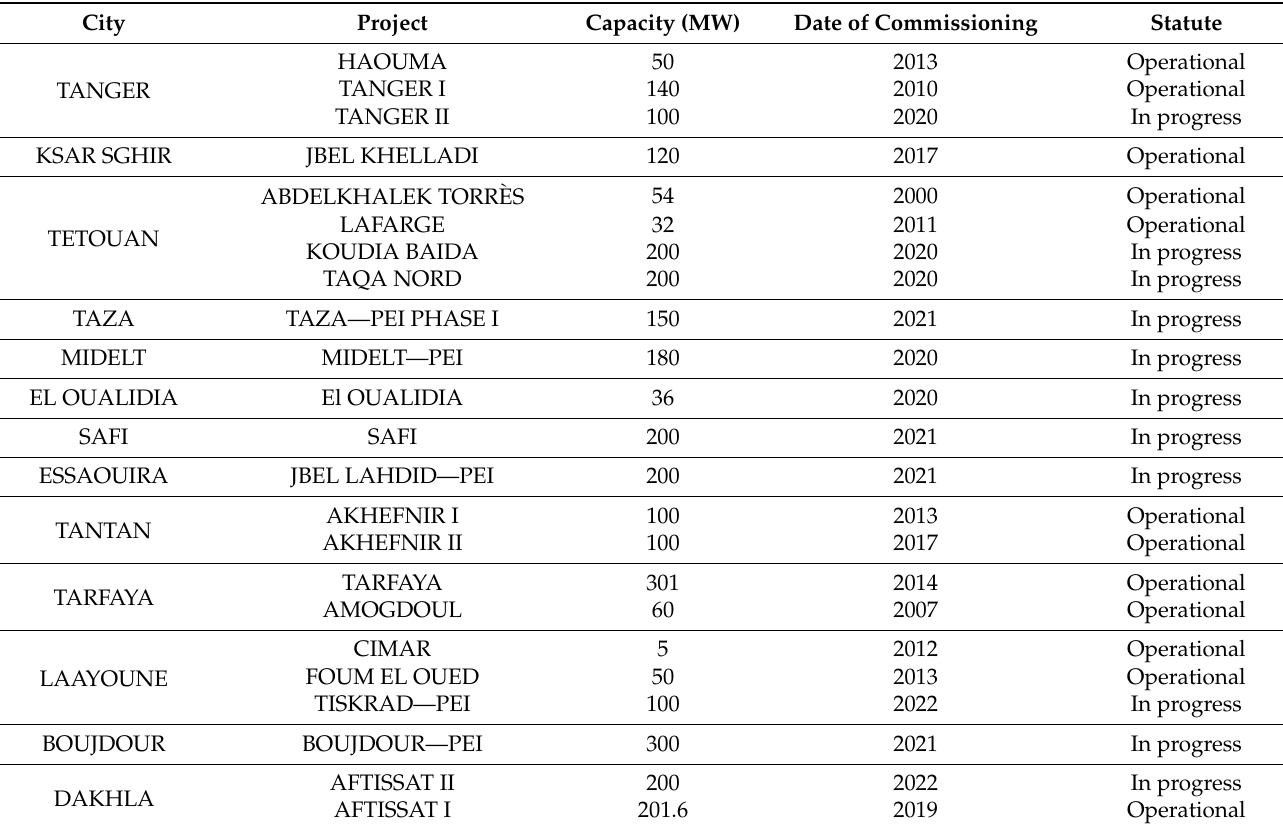
Table 1. Status of Morocco wind projects by the end of